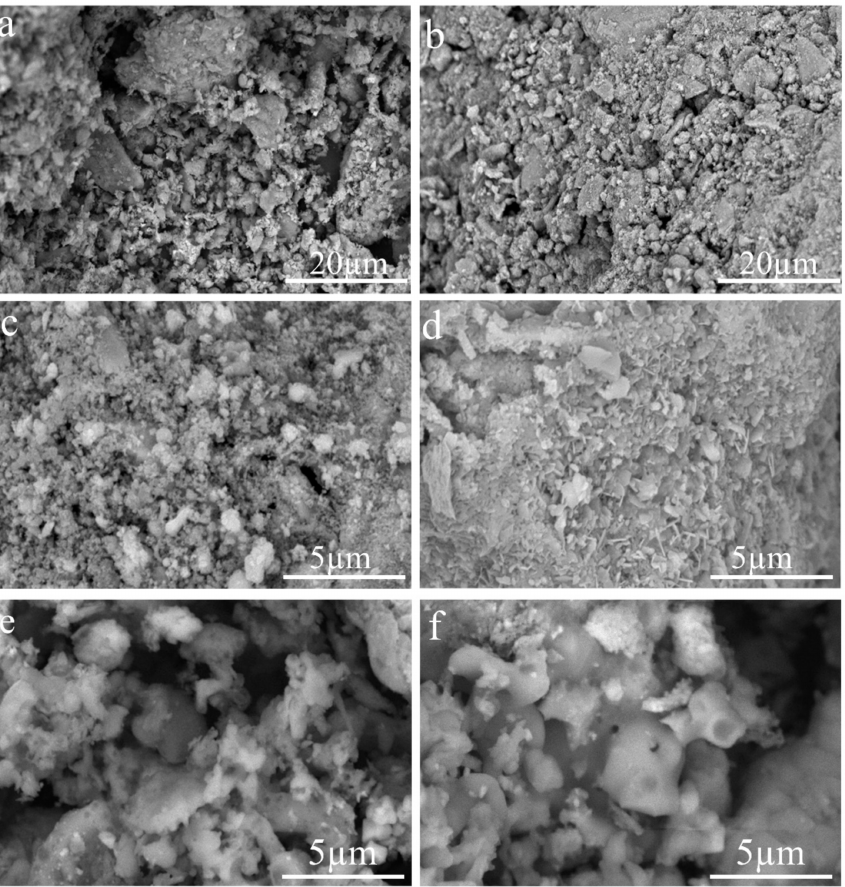
Figure 5. SEM image of coal ash and steel slag. ( a ) Raw coal ash ( b ) Steel slag ( c ) Steel slag after calcination ( d ) Modified steel slag after calcination ( e ) F 2 ( f ) F 3